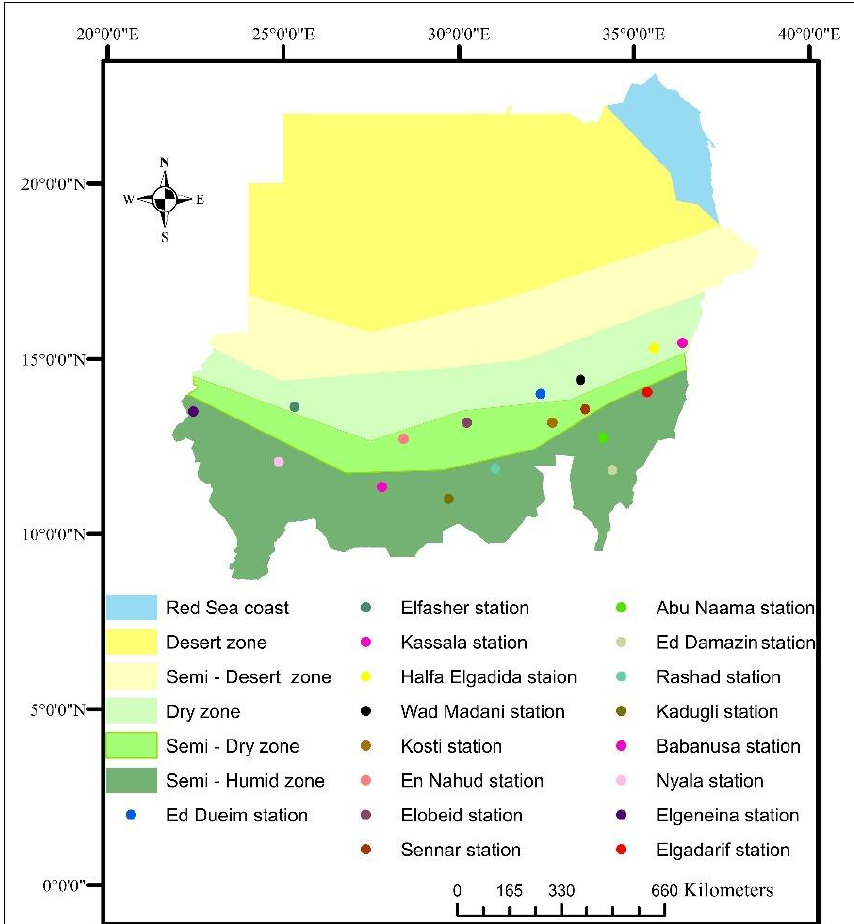
Figure 2. Climatic zones and locations of rain gauges over